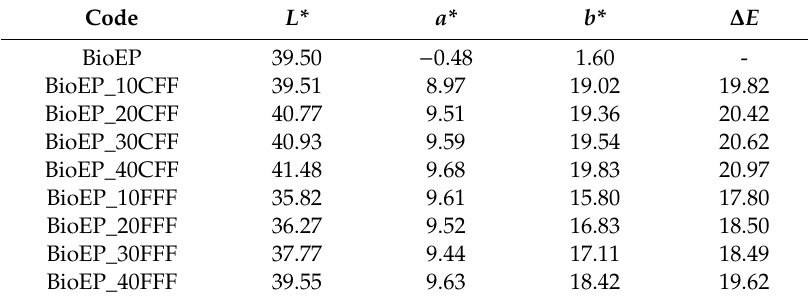
Table 5. Color parameters from the CIELab space of BioEP resin and BioEP composites reinforced with di ff erent CFF and FFF